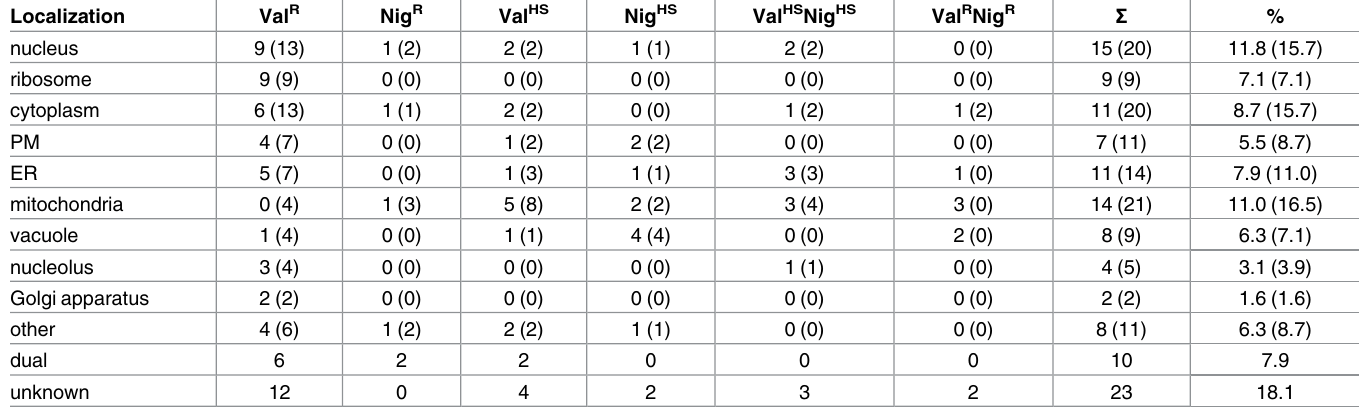
Table 3. Summary of the numbers of strains categorized based on the localization of the corresponding proteins (see also Fig 3). PM, plasma membrane; ER, endoplasmic reticulum, values in brackets include dual localizations.